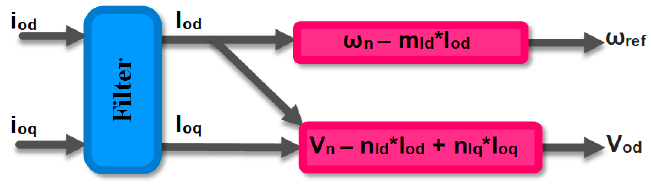
Figure 12. Current droop-based CVR controller [102].